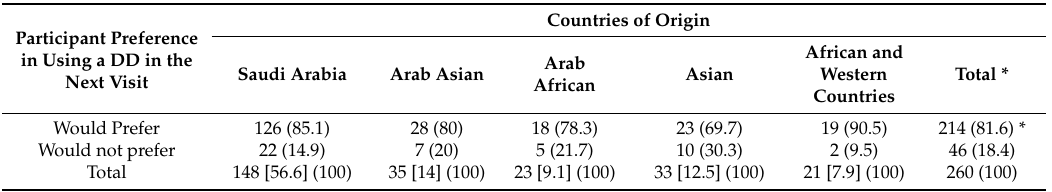
Table 1. Participant preferences for using a dental-dam (DD) in the next visit (%) and its correlation with participant countries of